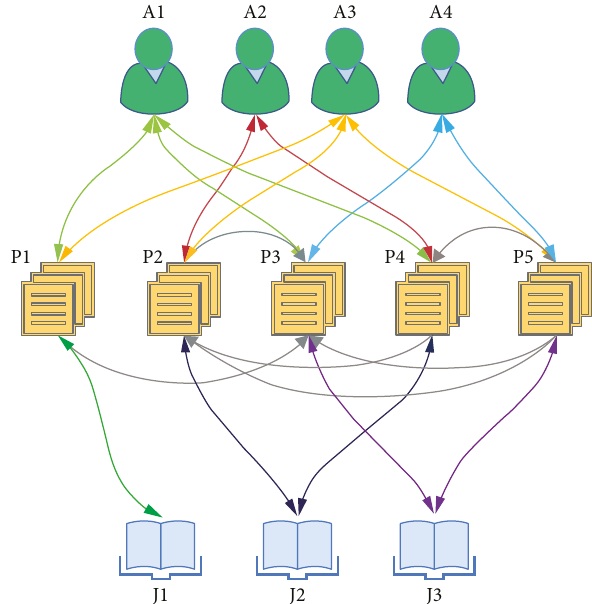
Figure 2: Illustration of a heterogeneous academic network, where P1 to P5 represent the papers, A1 to A4 indicate their corresponding authors, and J1, J2, and J3 represent the